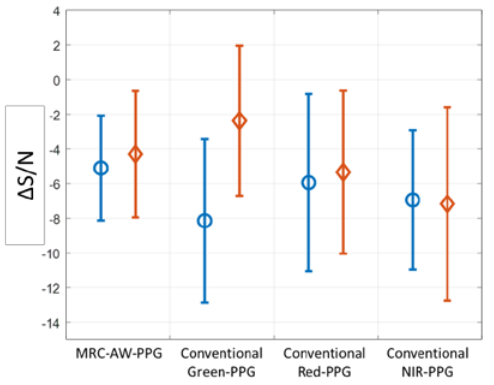
Figure 12. The ∆ S / N of the proposed MRC-AW-PPG against conventional green, red, and near-infrared of the proposed MRC-AW-PPG against conventional green, red, and Figure 12. The Figure 12. Figure 12. near-infrared (NIR) PPG sensors. means difference between hands forward and hands up; ∆𝑆𝑆 / 𝑁𝑁 (NIR) PPG sensors. means di ff erence between hands forward and hands up; means difference between hands forward and hands down. between hands forward and hands